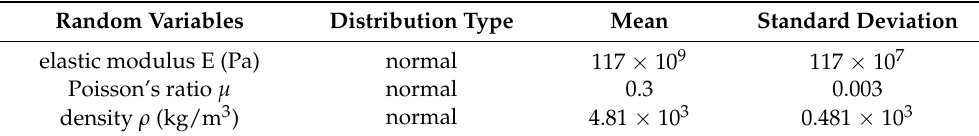
Table 2. The list of random variables.